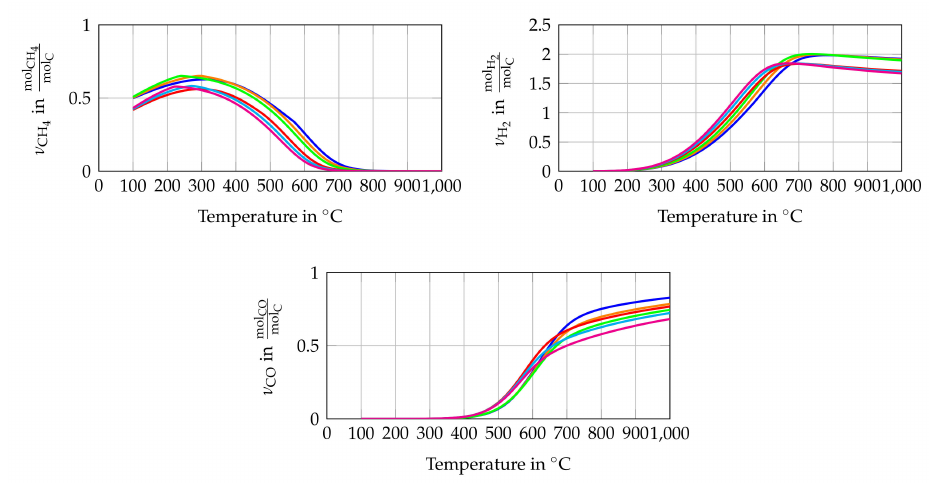
Figure 3. Chemical equilibrium composition in amount of mole ( a ) CH 4 ( b ) H 2 and ( c ) CO per mole carbon for gas composition 1 , gas composition 2 , gas composition 3 , gas composition 4 , gas composition 5 , gas composition 6